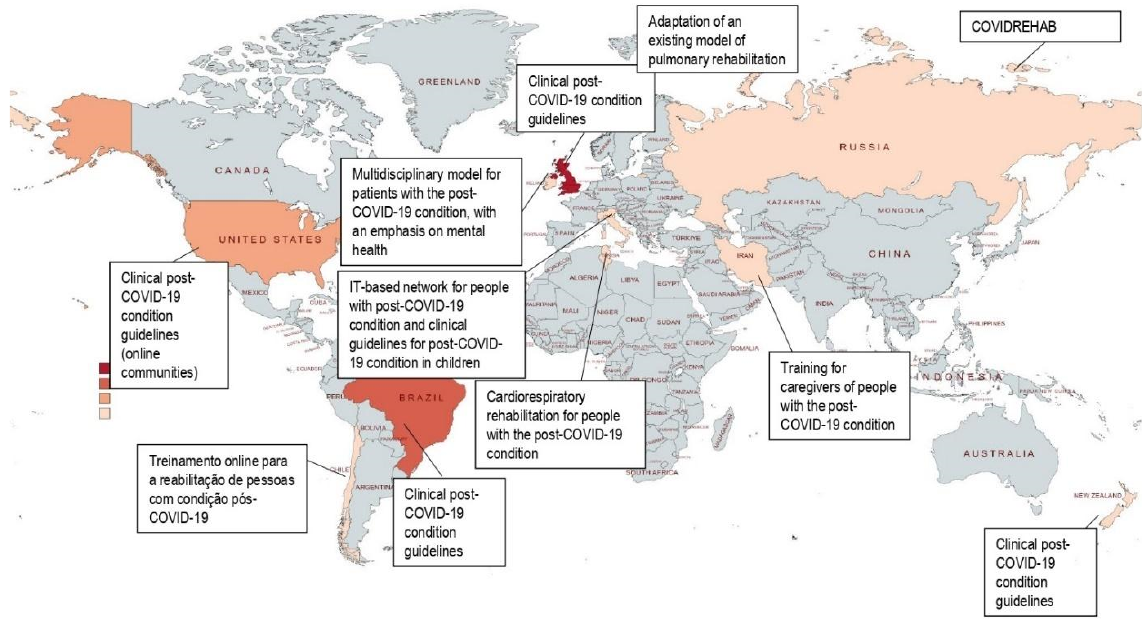
Figure 2. Health policies and models of social support for caregivers and patients with the post ‐ COVID ‐ 19 condition.